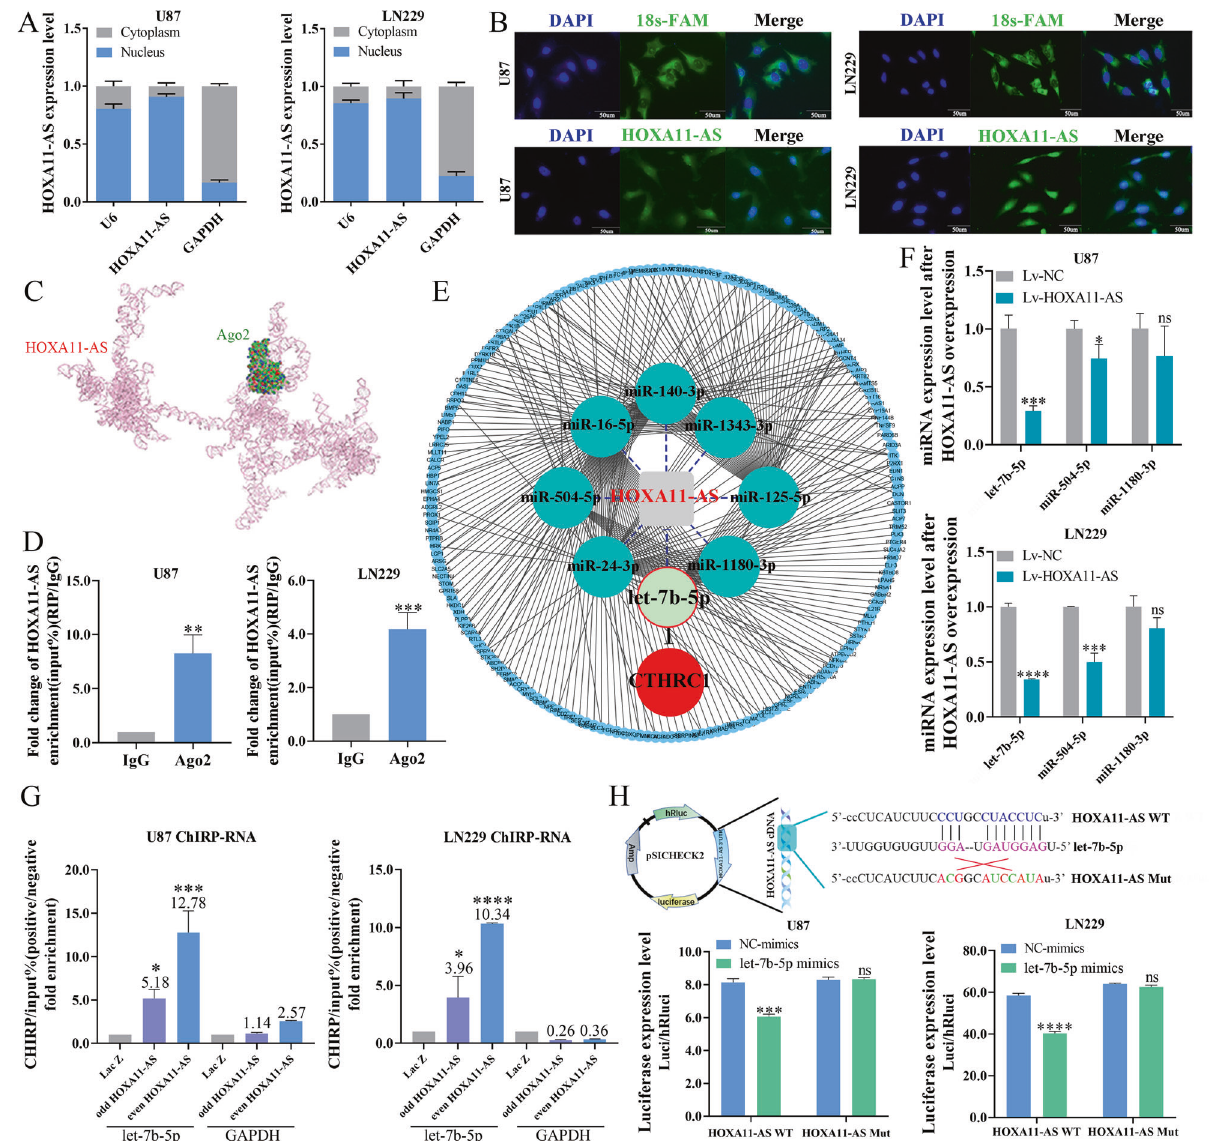
Fig. 2 Exploration about the ceRNA mechanism of HOXA11-AS in cytoplasm. The subcellular localization of HOXA11-AS was veri fi ed by RT- qPCR ( A ) and FISH ( B ) experiments in U87 and LN229 cell lines. C The binding mode of HOXA11-AS to Ago2 protein was predicted via molecular docking analysis. D The binding of HOXA11-AS to Ago2 protein was veri fi ed by RIP experiment. E The ceRNA network diagram was constructed by mRNA and small RNA sequencing after HOXA11-AS overexpression in U87 cell line. F The expression of let-7b-5p, miR-504-5p, and miR-1180-3p in U87 and LN229 cells infected with Lv-HOXA11-AS were quanti fi ed by RT-qPCR. G The combination of HOXA11-AS and let- 7b-5p was veri fi ed by ChIRP assay. H Luciferase reporter assay in U87 and LN229 cells co-transfected with let-7b-5p mimics, pSICHECK2-wild type HOXA11-AS (WT) or pSICHECK2-mutant type HOXA11-AS (Mut) plasmids. * P < 0.05, ** P < 0.01, *** P < 0.001, **** P <